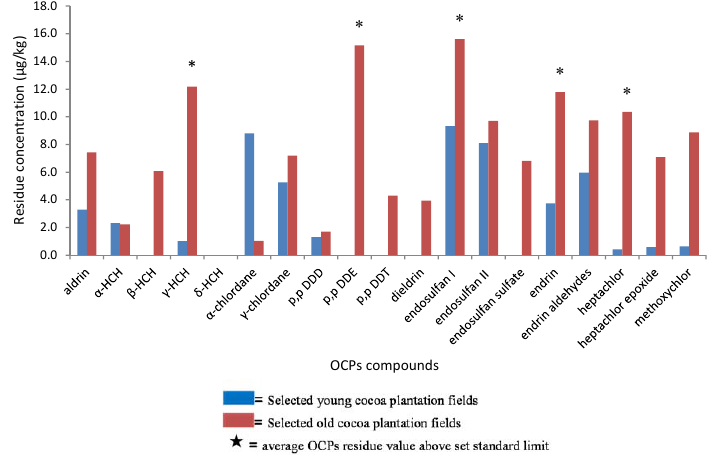
Fig. 2b : Organochlorine pesticides residue profile level in cocoa plantation soil of Ekiti State